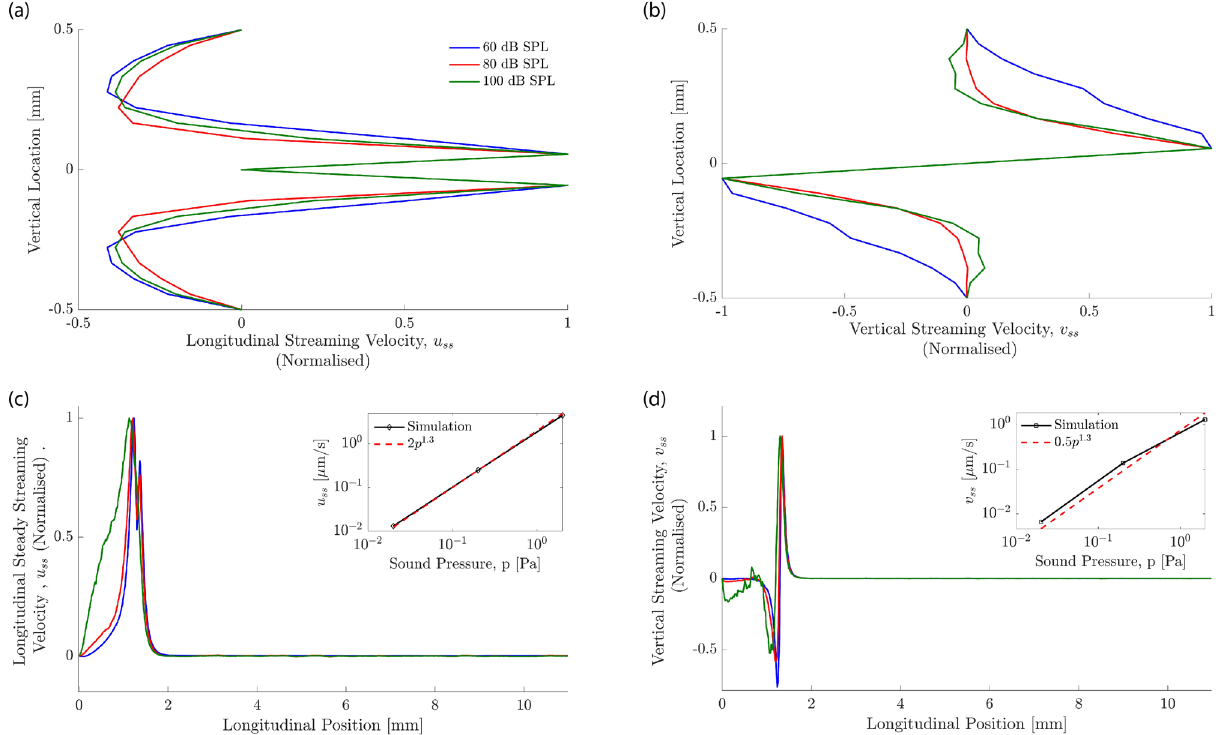
Figure 4. Steady-streaming velocity profiles at different sound intensities for 20 kHz stimulation taken at 1.2mm , the 20 kHz resonance location. The velocity profiles have been normalized by the maximal velocity. x = ( a ) The longitudinal streaming velocity is largest close to the basilar membrane. The vertical extent around the basilar membrane over which fluid flow occurs towards the apex is slightly larger at higher sound intensities. ( b ) The vertical streaming velocity peaks at a similar distance from the basilar membrane as the longitudinal component. The kinks seen in these profiles are an artefact of the coarse resolution of the streaming field but do not affect the overall accuracy of the calculation. ( c ) The longitudinal streaming velocity close to the basilar membrane. The inset shows that the maximal value of u ss increases approximately as a power law with the p 1.3 . ( d ) The vertical streaming velocity shows that, for high frequencies at higher the sound pressure p : u ss ∼ sound-pressure levels (eg. 100 dB SPL), the boundary at the base of the cochlea influences the flow. The inset shows the power law dependence of the maximal value of v ss on the sound pressure level p which follows p 1.3 . approximately a power law, v ss ∼